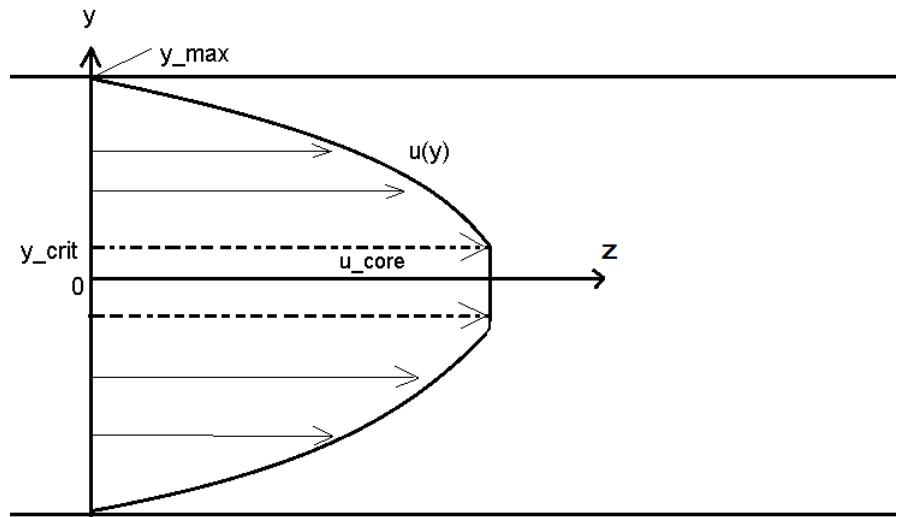
Figure 1. The Casson flow